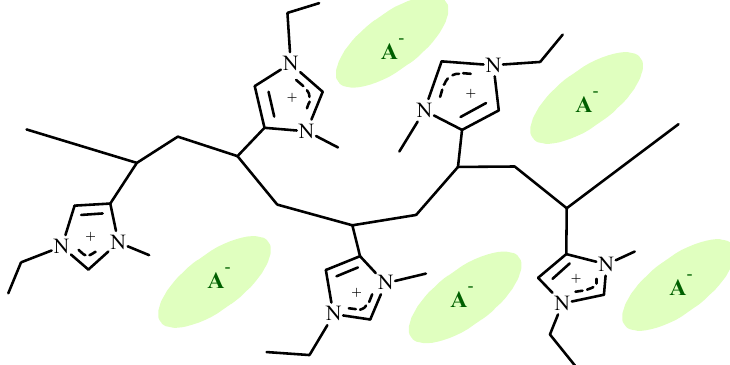
Figure 1. Pentad segment of a 1-ethyl-3-methyl-4-vinylimidazolium polymer.